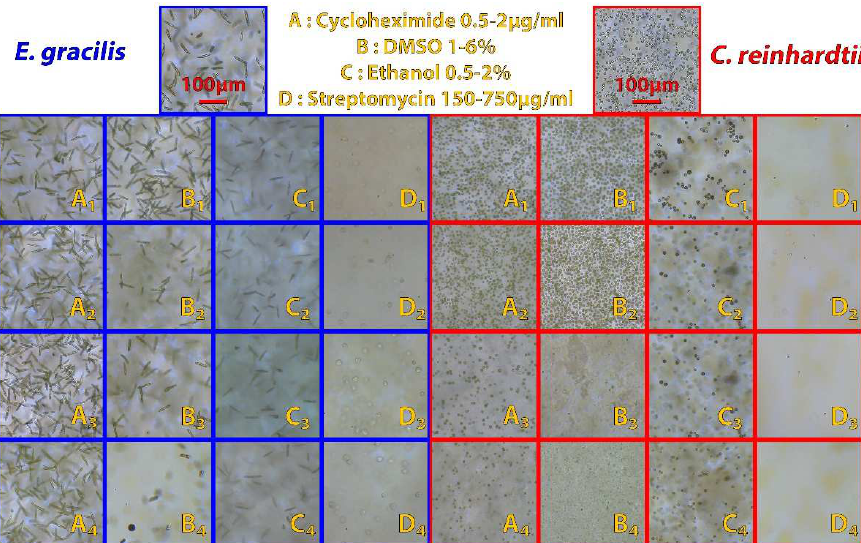
Figure 12. Observation of the evolution of morphology of algal cells exposed to chemicals. Briefly, 2 mL cultures of E. gracilis (blue) and C. reinhardtii (red) with an initial concentration of 10 5 cells/mL were exposed during 10 days to different concentrations of cycloheximide (0.5 µg/mL, A1; 1 µg/mL,